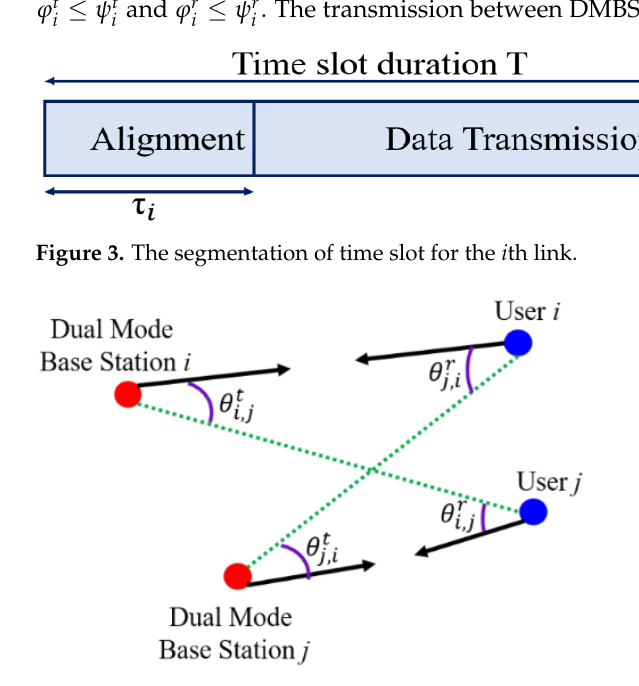
Figure 4. Transmission between DMBS and UEs.